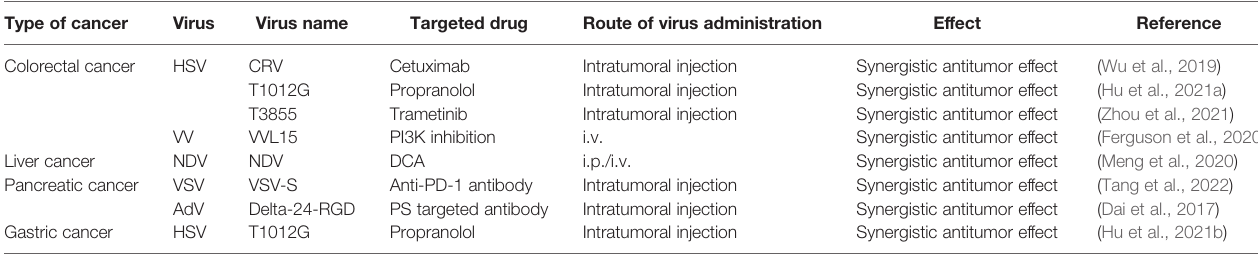
TABLE 3 | Oncolytic viruses combined with targeted